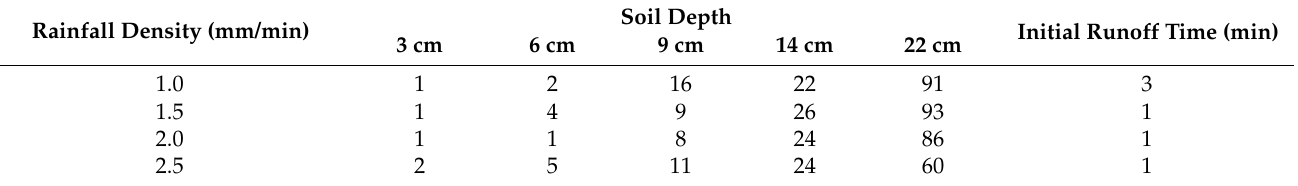
Table 4. The rising time of soil water content curves at different depths on loess